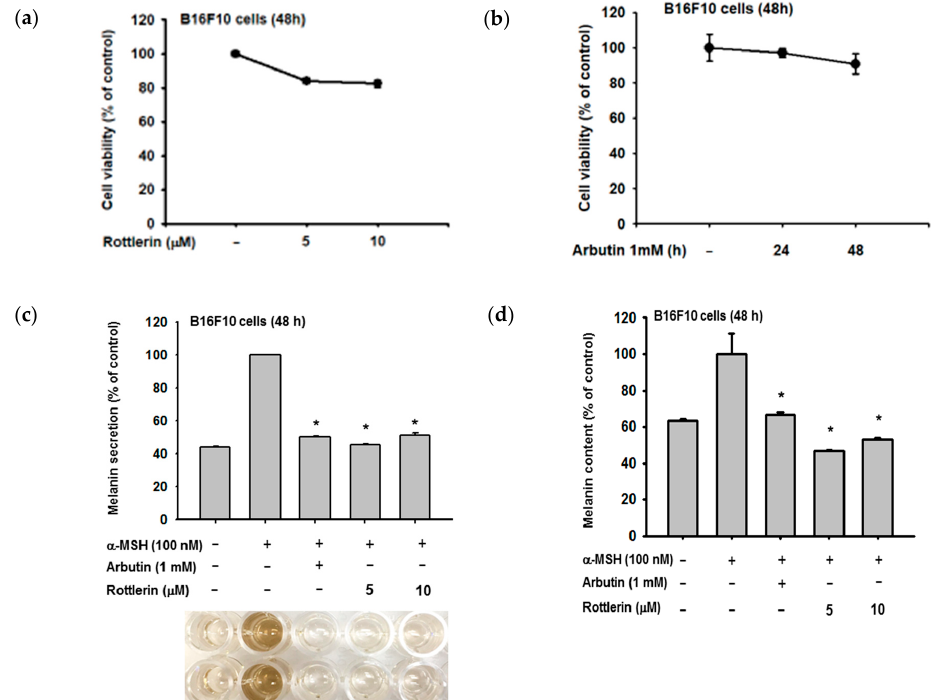
Figure 2. E ff ect of rottlerin on alpha-melanocyte stimulating hormone ( α -MSH)-induced melanogenesis in melanoma cells. ( a ) and ( b ) Viability of B16-F10 cells after rottlerin treatment (5 and 10 µ M) and arbutin (1 mM at 48 h) was assessed with MTT solution. ( c ) Extracellular and ( d ) intracellular melanin contents in B16-F10 cells (10 5 cells / mL) induced with α -MSH (100 nM), treated with rottlerin (5 and 10 µ M) or arbutin (1 mM) as a positive control for 48 h were determined by spectrophotometry. All data ( a – c ) are expressed as the mean ± the standard deviation (SD) of three replicates. * p < 0.05 compared to control or normal